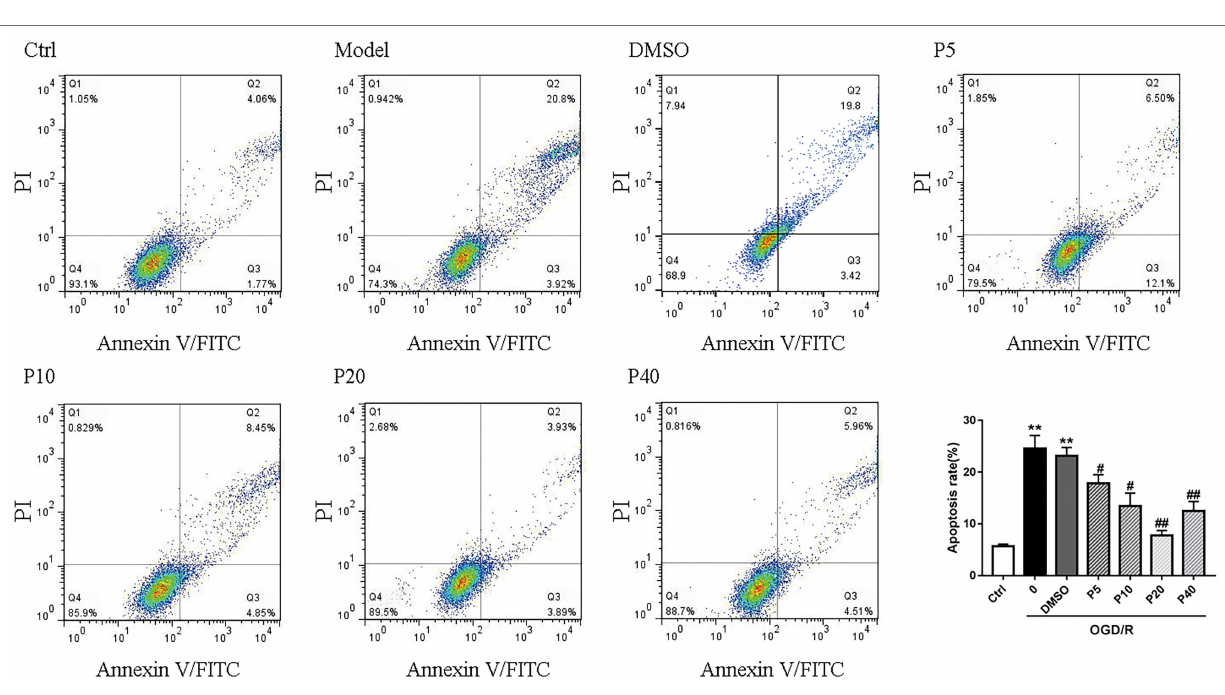
FIGURE 2 | Propofol inhibited cell apoptosis induced by OGD/R in H9c2 cells. Quantification of the apoptotic cell population by flow cytometry. Propofol decreased the percentage of apoptotic cells compared with the model. The data are presented as the mean ± SD of three independent experiments. * p < 0.05, ** p < 0.01, *** p < 0.001 versus control, # p < 0.05, ## p < 0.01, ### p < 0.001 versus OGD/R treated group without drugs.